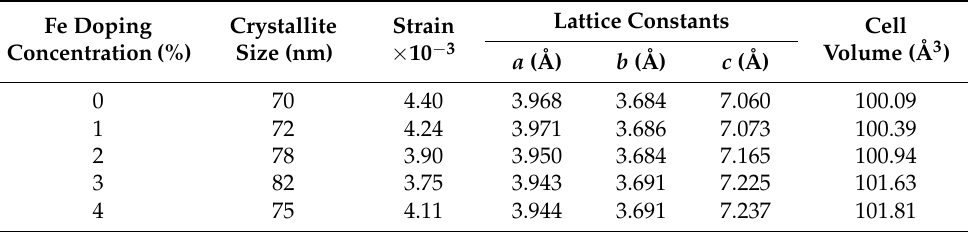
Table 1. Structural parameters and lattice constant values of Fe doped MoO 3 thin films with different Fe doping concentrations.